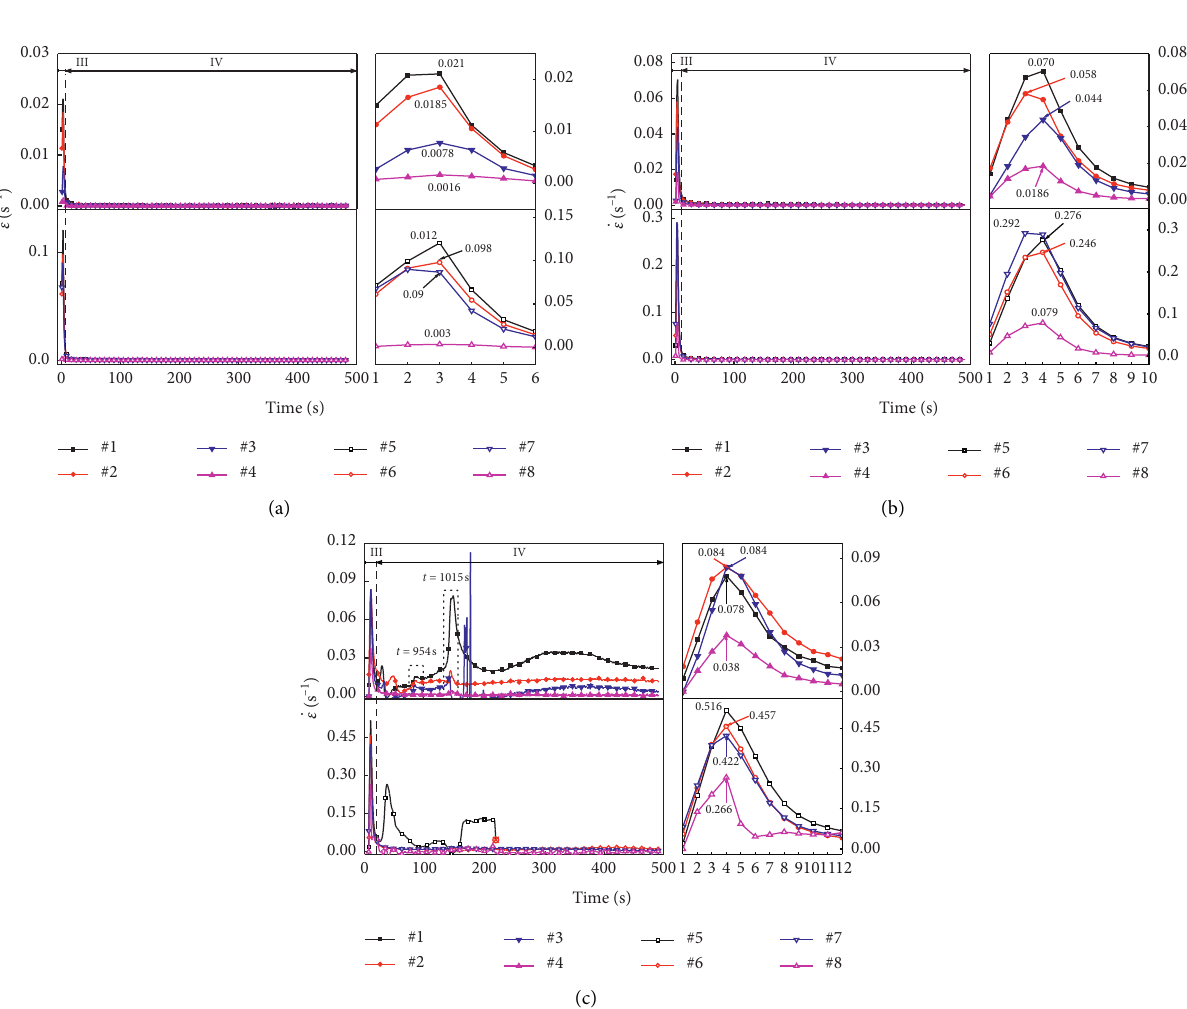
Figure 7: Radial strain rates during unloading stage and maintaining after unloading in different initial confining stress ((a) 10, (b) 20, and (c)